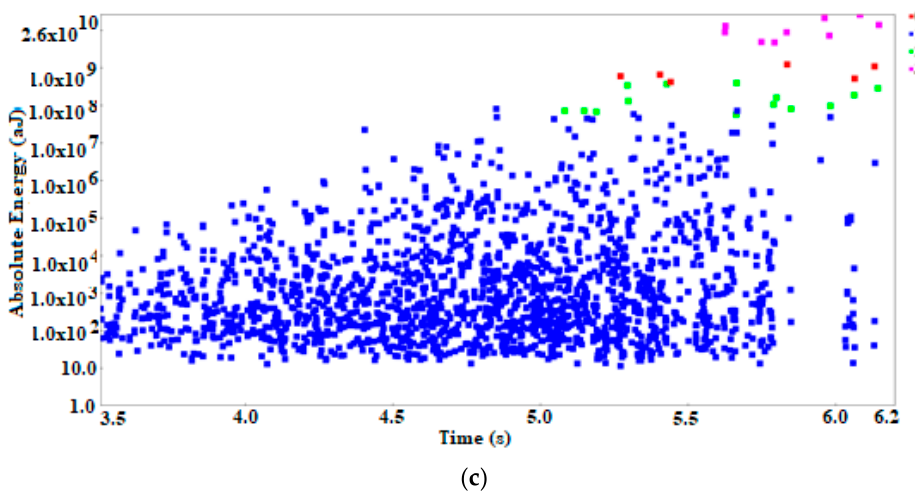
Figure 5. Scatterplots of acoustic emission signals: ( a ) Force (kN) vs. time (s); ( b ) ASL (dB) vs. time (s); and ( c ) absolute energy (a) vs. time (s).